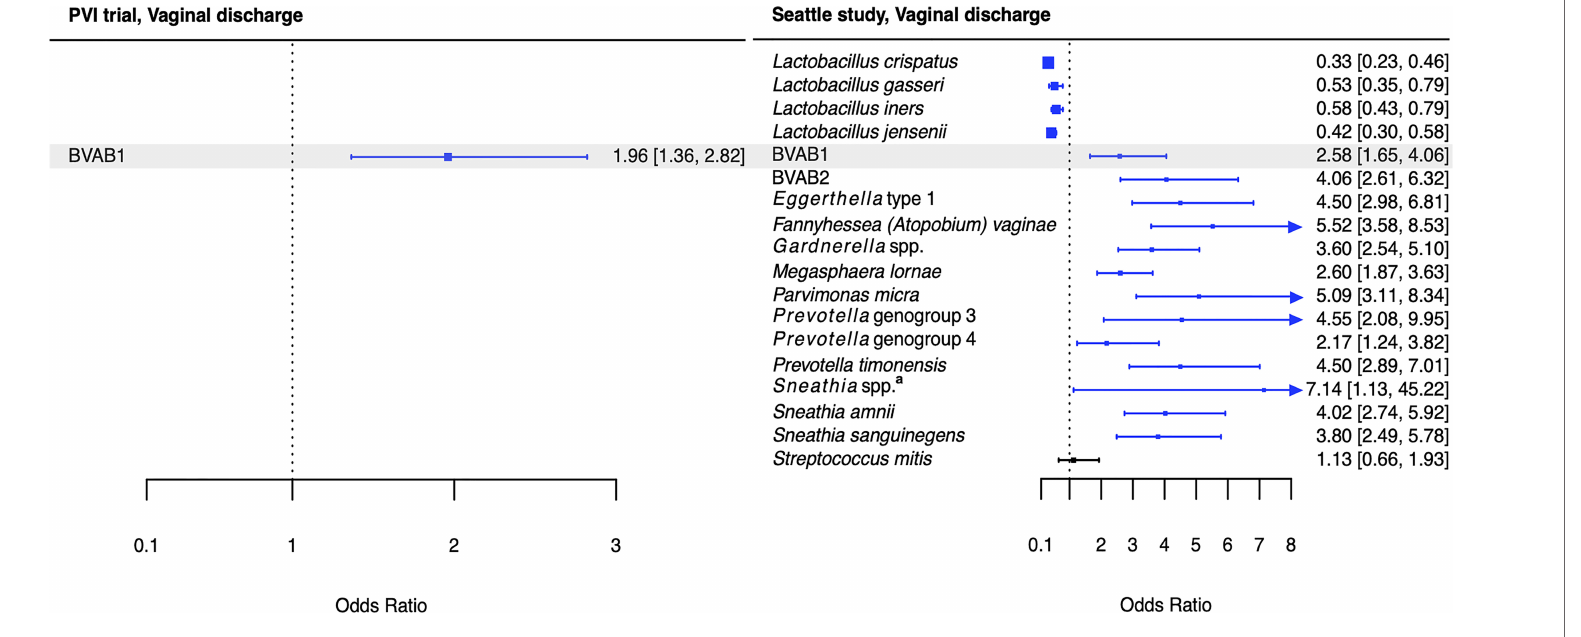
FIGURE 4 | Logistic regression modeling results for the association between vaginal bacteria and vaginal discharge. Gray shading indicates taxa that were modeled in both study populations. Blue box and whiskers indicate associations that were signi fi cant following Benjamini-Hochberg multiple comparisons adjustment (5% false discovery rate), and black box and whiskers indicate associations that were not signi fi cant following multiple comparisons adjustment. All models were univariable logistic regression models with the Amsel criterion as the outcome and bacterial relative abundance as the exposure. Bacterial relative abundances were modeled as tertiles with the reference level being no detection (four-level ordinal variables with levels: no detection, tertile 1, tertile 2, tertile 3). Generalized estimating equations with an independent correlation structure were used for PVI trial models, and no variables were lagged in PVI models. a Sneathia spp. includes those not classi fi ed at the species level as S . amnii or S . sanguinegens , but closely related to these two species. Sequences are not suf fi ciently different at the V3-V4 region of the 16S rRNA gene to classify at the species level, hence classi fi ed at the genus level. PVI, Preventing Vaginal Infections; OR, odds ratio; CI, con fi dence interval; BVAB, bacterial vaginosis associated